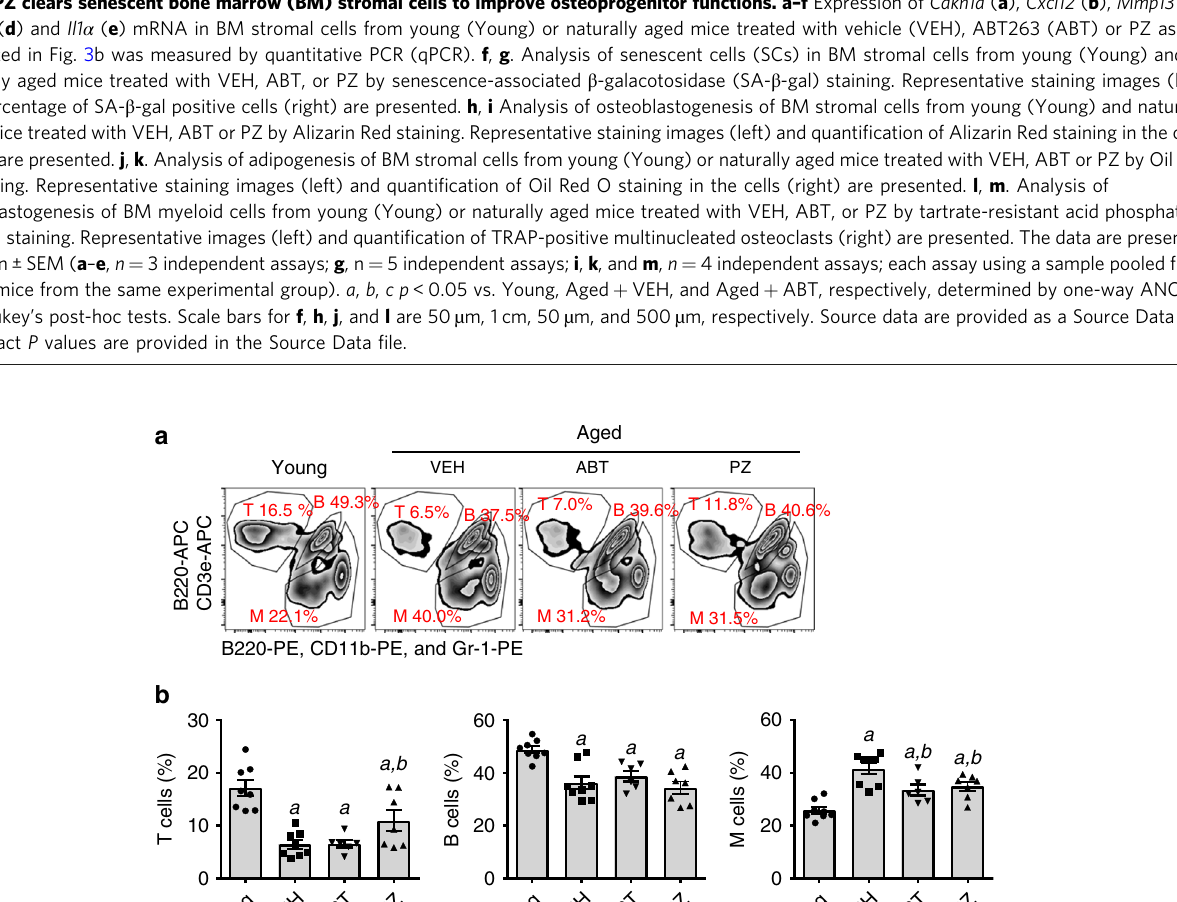
Fig. 4 PZ clears senescent bone marrow (BM) stromal cells to improve osteoprogenitor functions. a – f Expression of Cdkn1a ( a ), Cxcl12 ( b ), Mmp13 ( c ), Tnfsf11